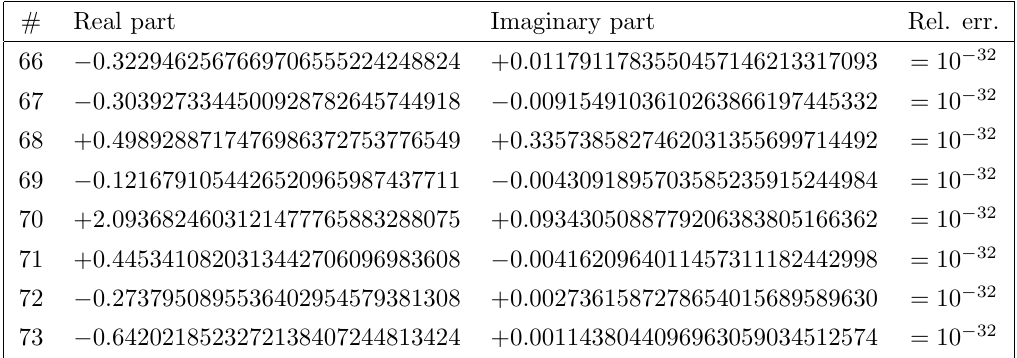
Table 2 . Numerical results for the elliptic sectors in the point s 12 = 5 ; s 13 = (cid:0) 1 ; p 2 at order (cid:15) 4